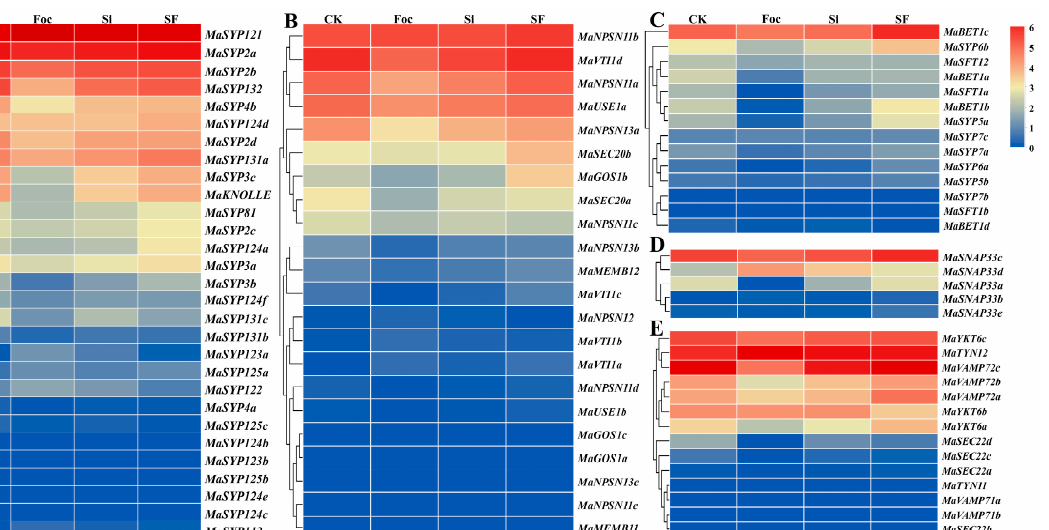
Figure 8. qRT-PCR analysis results of 10 selected MaSNARE s. Di ff erent lowercase le tt ers above the columns represent signi fi cant di ff erences at p < 0.05 level.